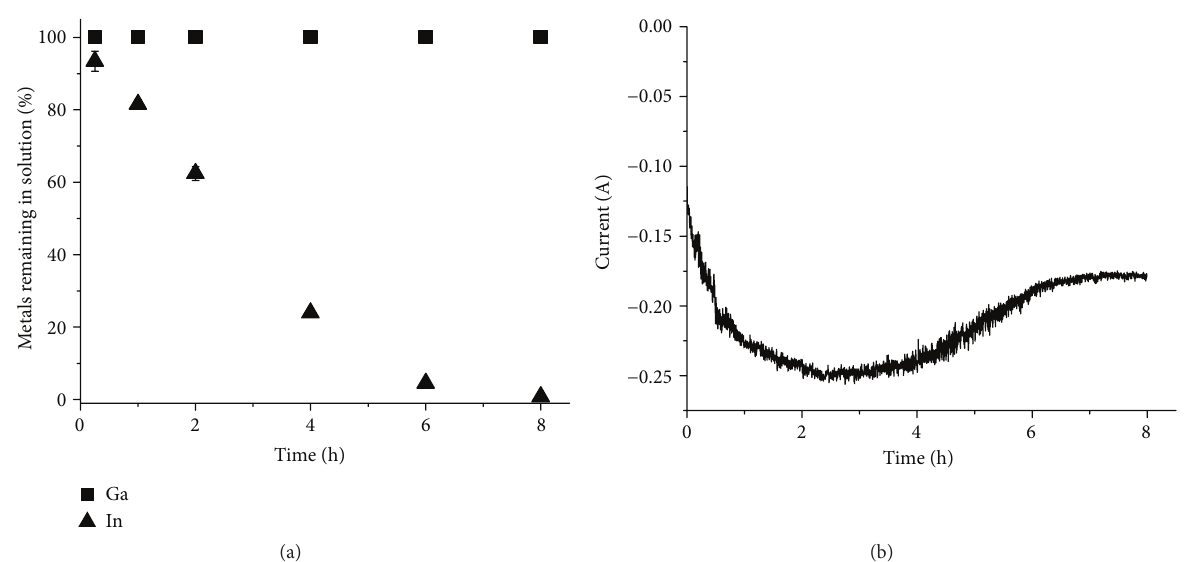
Figure 11: Electrochemical separation of indium from a solution prepared by dissolving prechlorinated CIGS waste material in 1M HCl (Solution 3). (a) The metal concentration in the solution relative to the original concentration as a function of time. (b) The current passed though the circuit as a function of